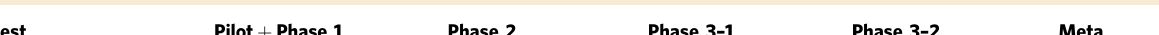
Table 1 Enrichment of association signals in promoter regions